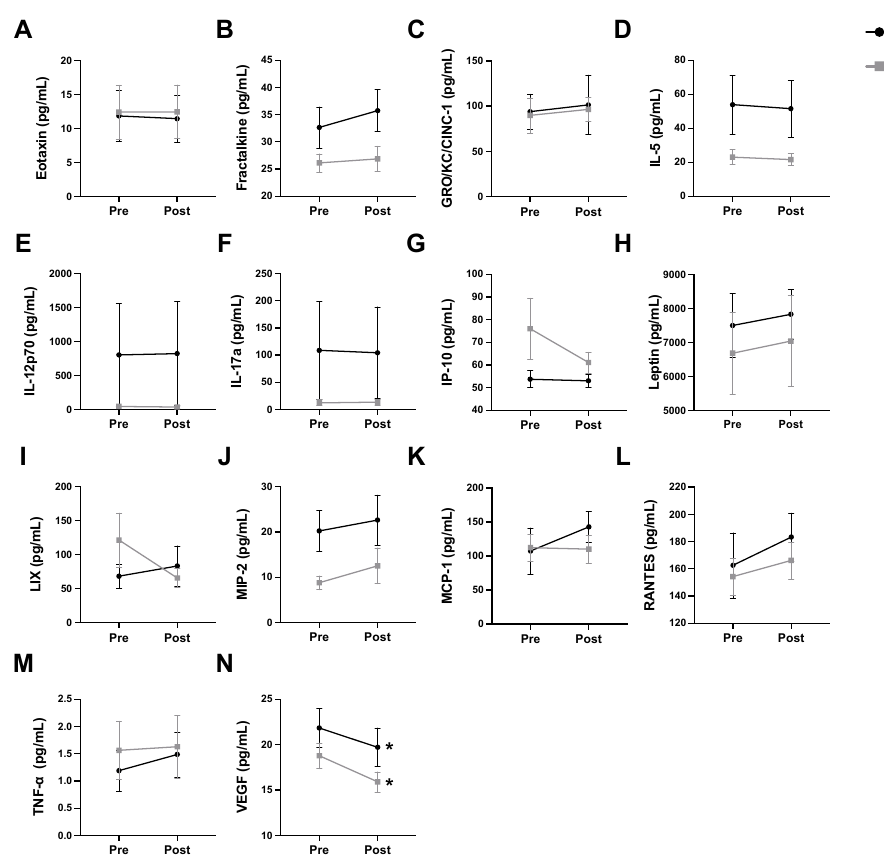
Figure 1. Alterations in Circulating Cytokines/Chemokines Pre- and Post-1-h of HBO Exposure at 2 or 3 ATA. Plasma levels of ( A ) eotaxin; ( B ) fractalkine; ( C ) GRO/KC/CINC-1; ( D ) interleukin-5 (IL-5); ( E ) interleukin-12p70 (IL-12p70); ( F ) interleukin-17a (IL-17a); ( G ) interferon gamma-induced protein 10 (IP-10 or CXCL10); ( H ) leptin; ( I ) LIX or C-X-C motif chemokine 5 (CXCL5); ( J ) macrophage inflammatory protein-2 (MIP-2); ( K ) monocyte chemoattractant protein-1 (MCP-1/CCL2); ( L ) regulated upon activation, normal T cell expressed and presumably secreted (RANTES); ( M ) tumor necrosis factor α (TNF- α ) and ( N ) vascular endothelial growth factor (VEGF). Values are represented as means ± SEM. * = Post-HBO significantly different from Pre-HBO ( p < 0.05). Echocardiography revealed significant systolic and diastolic myocardial dysfunction in all groups treated with DOX. LV fractional shortening percentage was reduced in all DOX-treated groups compared to CON (Figure 3A). PWSV was significantly reduced in the 2ATA-DOX group compared to CON, with trends for a reduction also apparent in the DOX ( p = 0.1475) and 3ATA-DOX ( p = 0.0592) groups compared to CON (Figure 3B). Assessment of the MPI revealed a significant increase in all DOX treated groups above CON (Figure 3C). The thickness of the posterior wall during systole and diastole (PWTs and PWTd) did not differ between groups. Septal wall thickness was significantly decreased in the 2ATA-DOX and 3ATA-DOX groups during systole (SWTs) compared to CON and 3ATA-DOX group compared to CON during diastole (SWTd) (Table